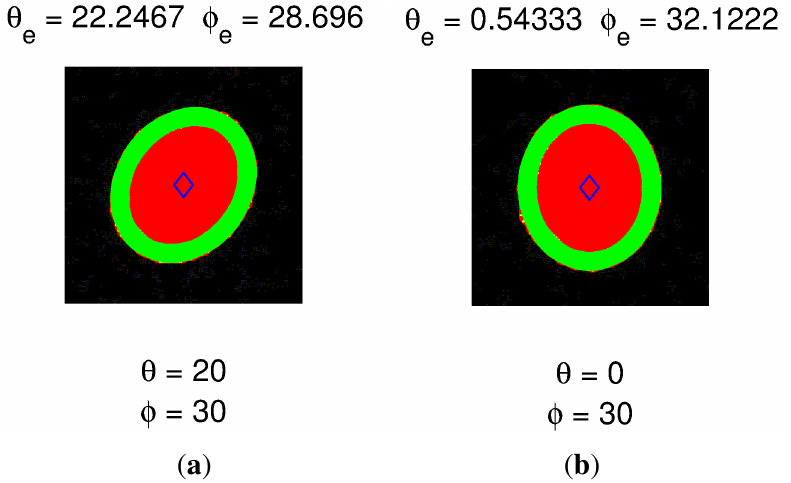
Figure 5. Result of IRED orientation angle estimation using the method proposed by [17]. Green points are the points that belong to the ellipse border, the red points represent all pixels of the IRED image and the blue point represents the center of the ellipse. The IRED orientation angle estimated by this method was subsequently used as the initial value for an optimization procedure, as will be explained in Section